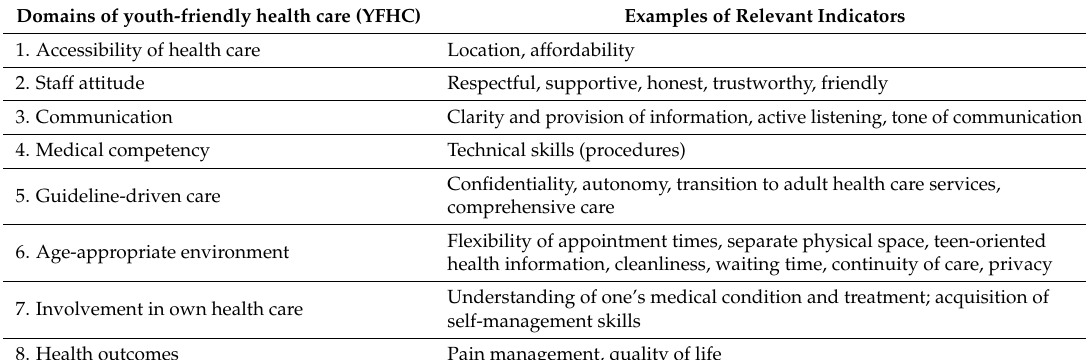
Table 3. Summary domains of adolescent-friendly care, with examples of relevant indicators [24].